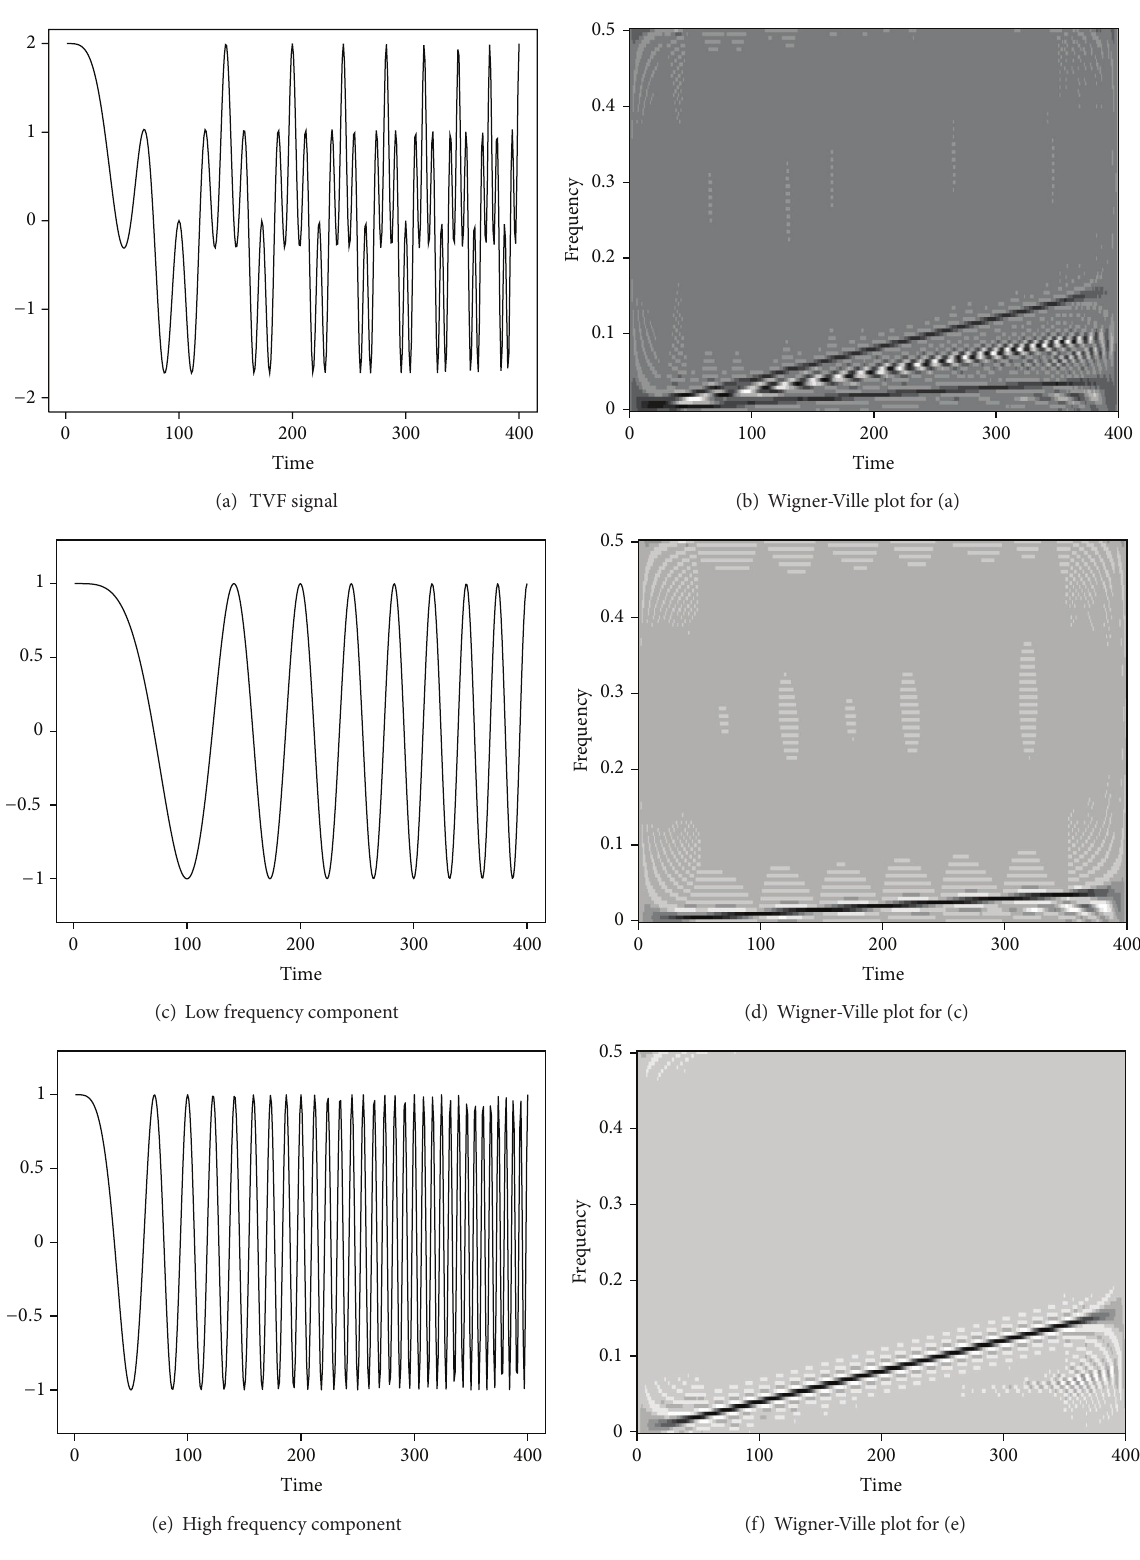
Figure 1: (a) A realization from the linear chirp model in Example 3; (b) the Wigner-Ville time-frequency plot for the data in (a); (c) lower frequency TVF component, 𝑌 1 (𝑡) ; (d) Wigner-Ville plot for the signal in (c); (e) higher frequency TVF component, 𝑌 2 (𝑡) ; (f) Wigner-Ville plot for the signal in